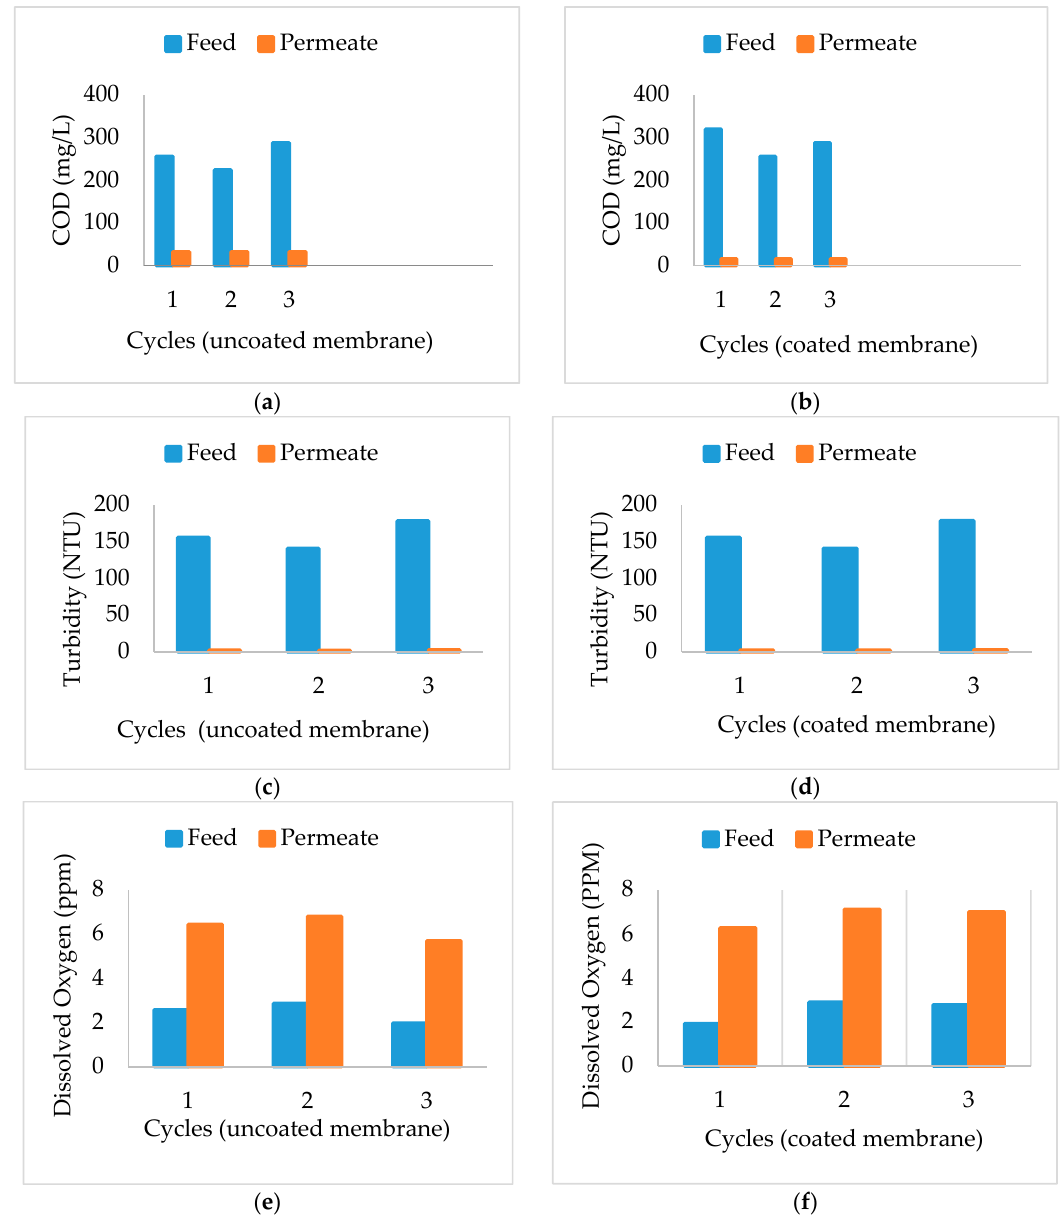
Figure 3. Variation in COD, Turbidity and DO for uncoated and coated membranes. (a) Variation in COD for uncoated membranes; (b) Variation in COD for coated membranes; (c) Variation in turbidity for uncoated membranes; (d) Variation in Turbidity for coated membranes; (e) Variation of DO for uncoated membranes; (f) Variation of DO for coated membranes.